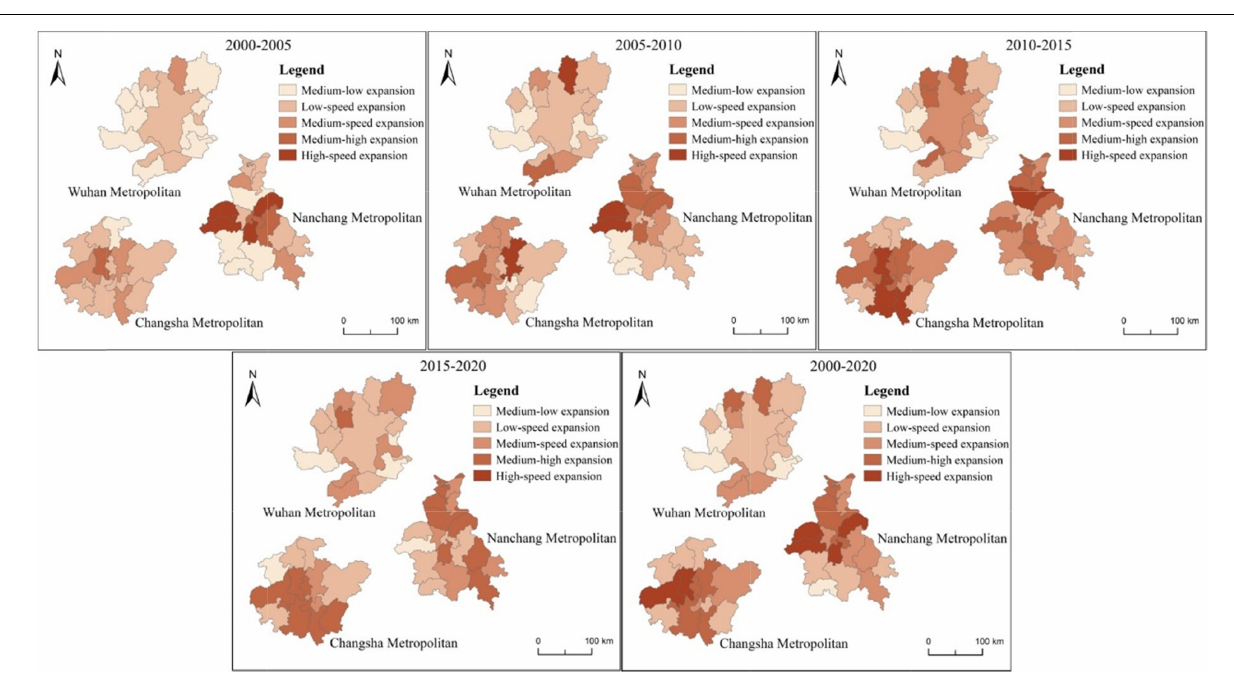
FIGURE 3 | Spatial pattern of difference of construction land expansion intensity in three metropolitan regions from 2000 to 2020.